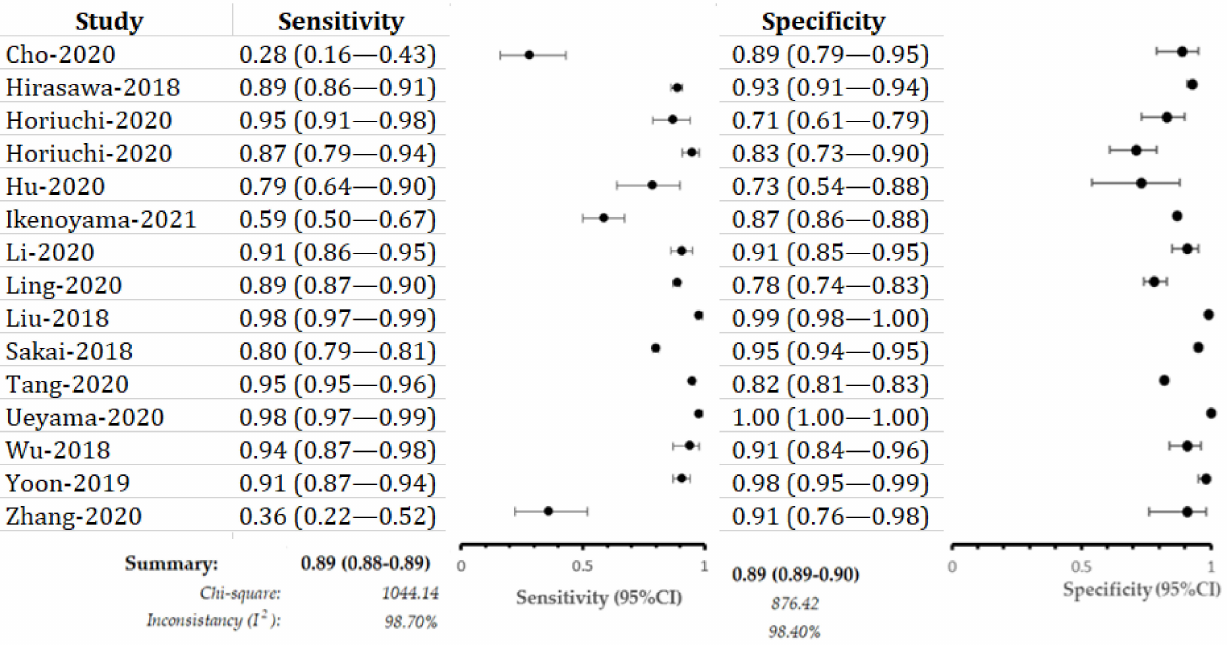
Figure 3. Sensitivity and specificity of included studies for EGC